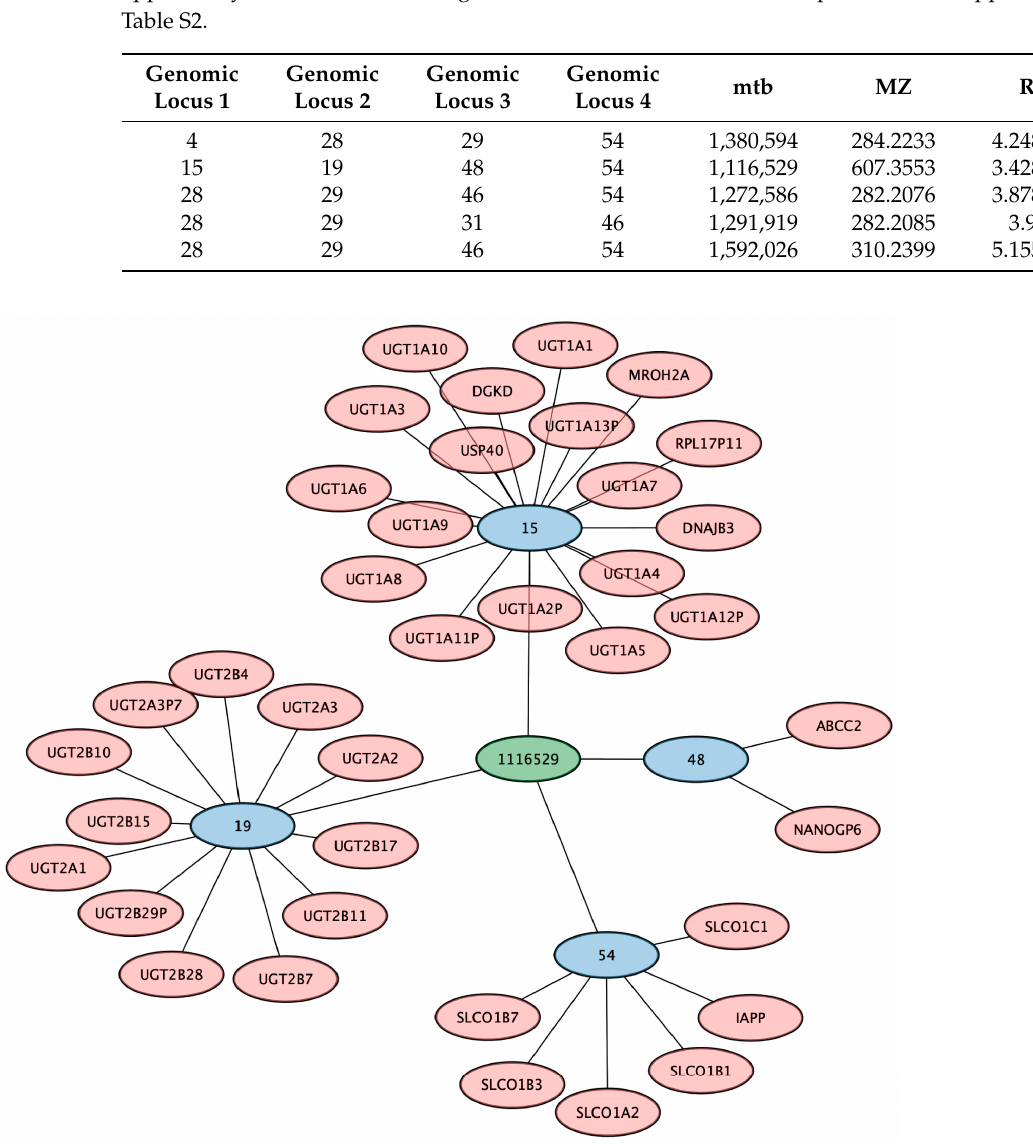
Table 2. Five of 7326 unidentified metabolites are associated with four unique combinations of genomic loci. These metabolites are associated with four unique combinations of genomic loci. The mass-to-charge ratio (MZ) and the retention time (RT) of each of the five metabolites are listed and indicate that metabolites 1272586 and 1291919 are likely to be very similar compounds. Genomic loci 28 ( ACSL6 ), 29 ( SLC22A4/5 ), 46 ( SLC16A9 ), and 54 ( SLCO1B1/3/7 , SLCO1A2 ) are associated with more than one metabolite, and genomic loci 4 ( SLC44A5 ), 15 ( UGT1A6/7/8/9/10 ), 19 ( UGT2B ), and 31 ( ECI2 ) appear only once. The full list of genes associated with each locus is presented in Supplementary